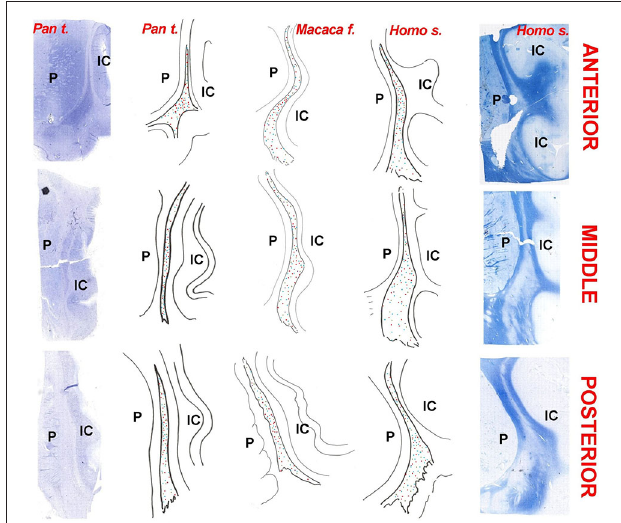
FIGURE 12 | Chartings of the claustrum of the chimpanzee ( Pan troglodytes ), crab-eating macaque ( Macaca fascicularis ), and man ( Homo sapiens ) . Column of photographs on the left: Nissl stain of the neurons in the claustrum of the chimpanzee; Column of photographs on the far right: Luxol fast-blue stain of fibers in the human claustrum. The chartings are drawn from original sections. The species is indicated on the top. Red dots: PV; Blue dots: CR; Green dots: NPY; Indigo dots: SOM (absent in the chimpanzee); P = putamen; IC: insular